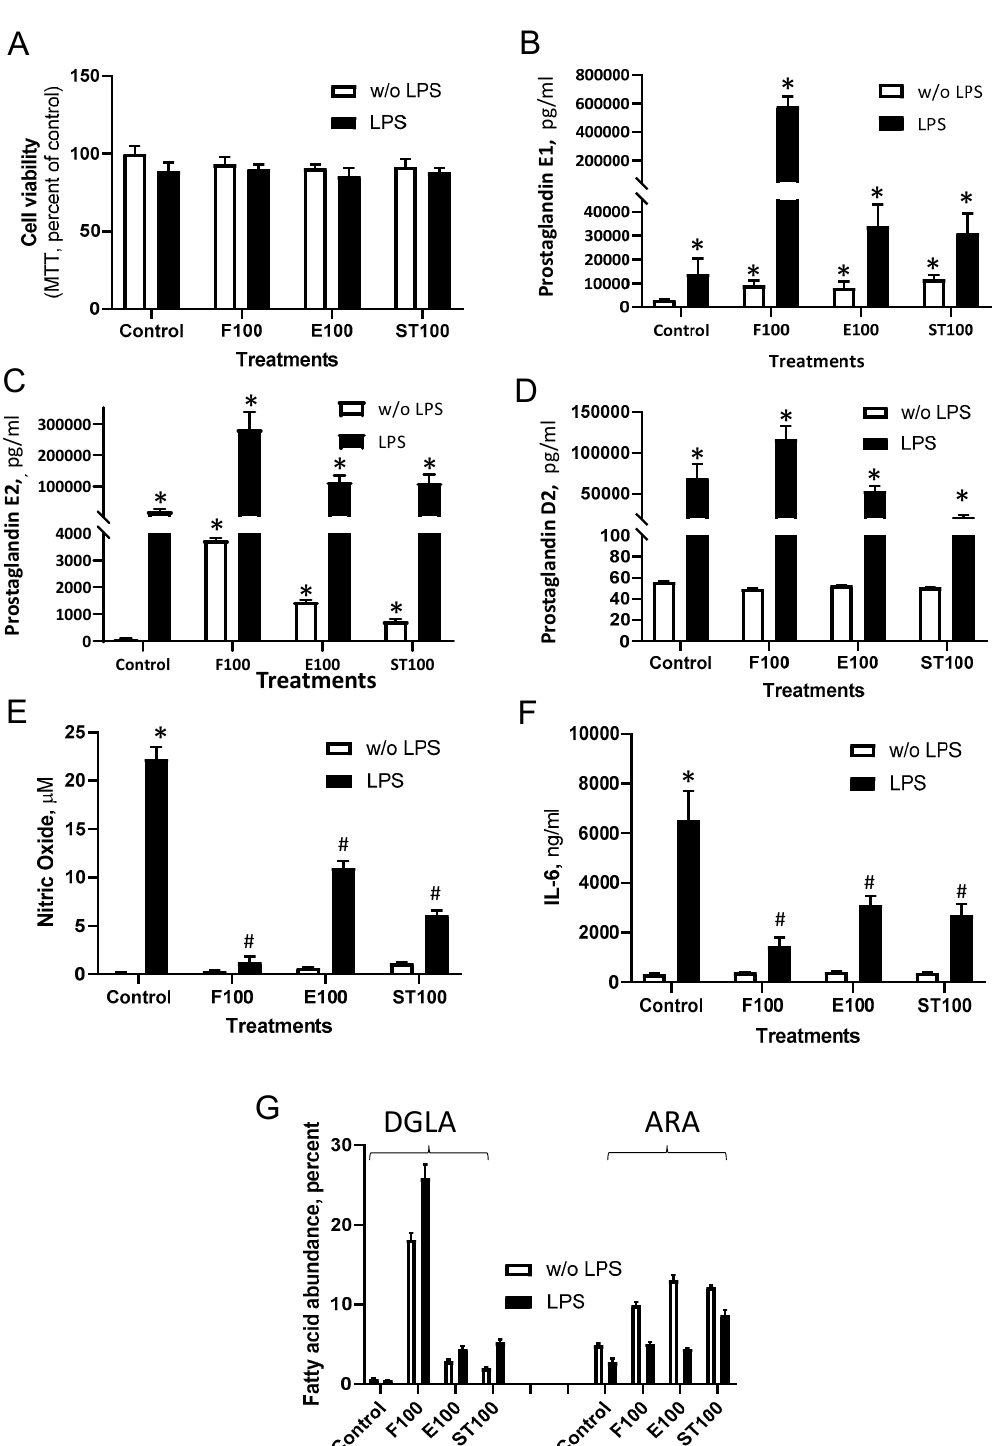
Figure 4. Synthetic and algae-derived DGLA modulate inflammation signals in RAW264.7 macrophages. Cells were treated as indicated in the legend of Figure 3. After 24 h, cell viability ( A ), PGE1, PGE2, and PGD2 ( B – D ), NO ( E ), and IL-6 ( F ) were quantified in culture supernatants. DGLA and arachidonic acid (ARA) levels in polar lipids (% of fatty acids) are presented in ( G ). Data are presented as mean ± SD. * / # denote a significant di ff erence compared to control (DMSO-treated) or LPS-induced cells, respectively, p < 0.05, n = 4. DGLA was administrated at 100 µ M in three forms: Free acid (F100), Ethyl esters (E100) and microalgae-derived ethyl esters (ST100),